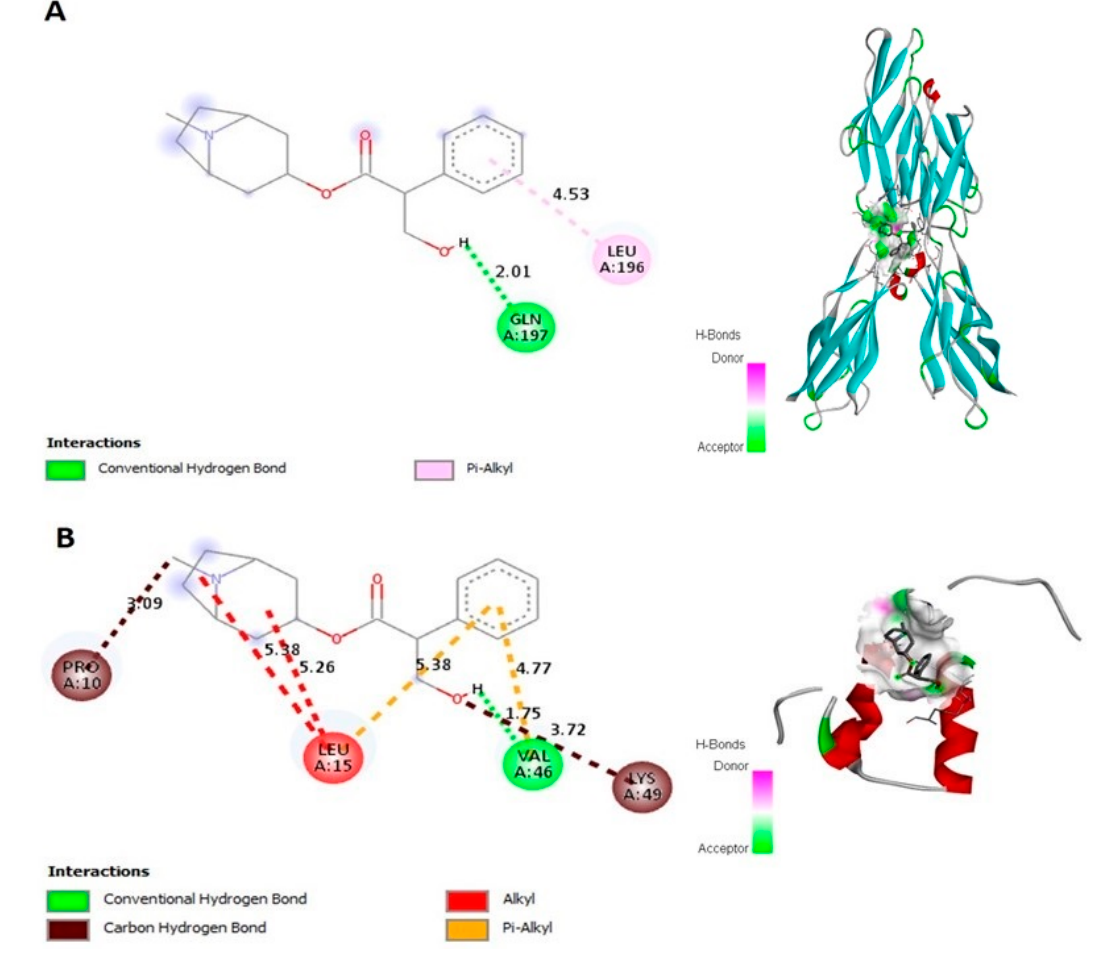
Figure 1. Molecular docking in silico docking of atropine (CID: 174174) and ( A ) Human E-cad (PDB-ID-1D5R) and ( B ) Human ZEB2 (PDB-ID-2D8V) proteins binding analysis. Computational binding was performed using AutoDock software to demonstrate the illustration of interactions in